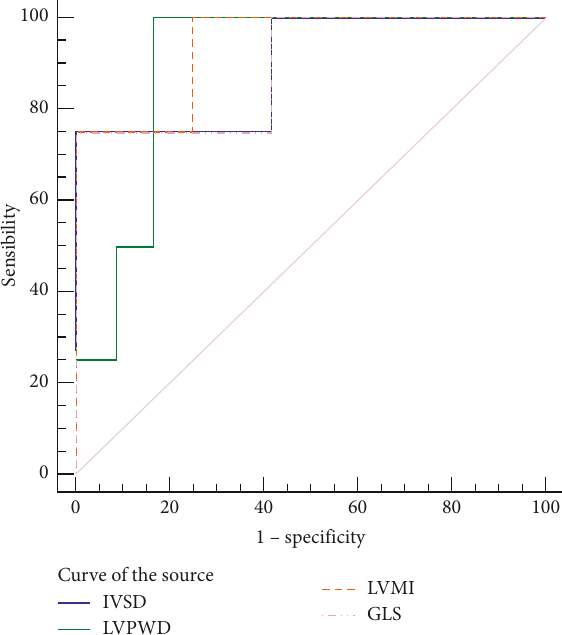
Figure 7: ROC curves of GLS and conventional 2D echocardiographic related